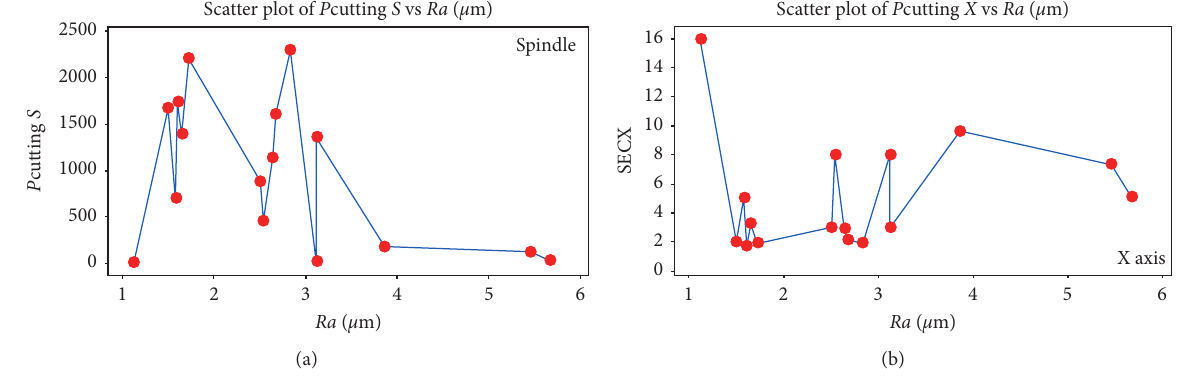
Figure 3: Scatter plots of P cutting S and P cutting X vs. Ra . Table 5: Experimental energy consumption results and S / N